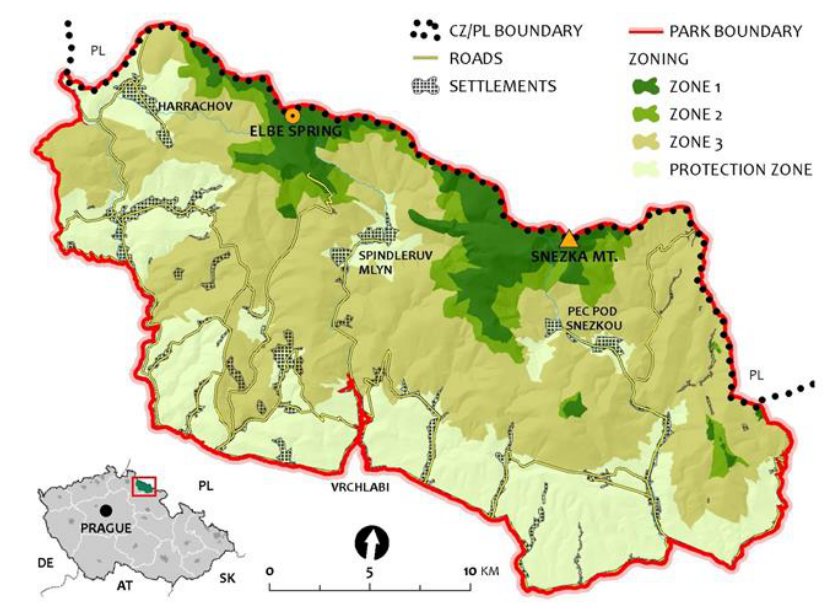
Fig. 1. The study area of Krkonoše Mountains National